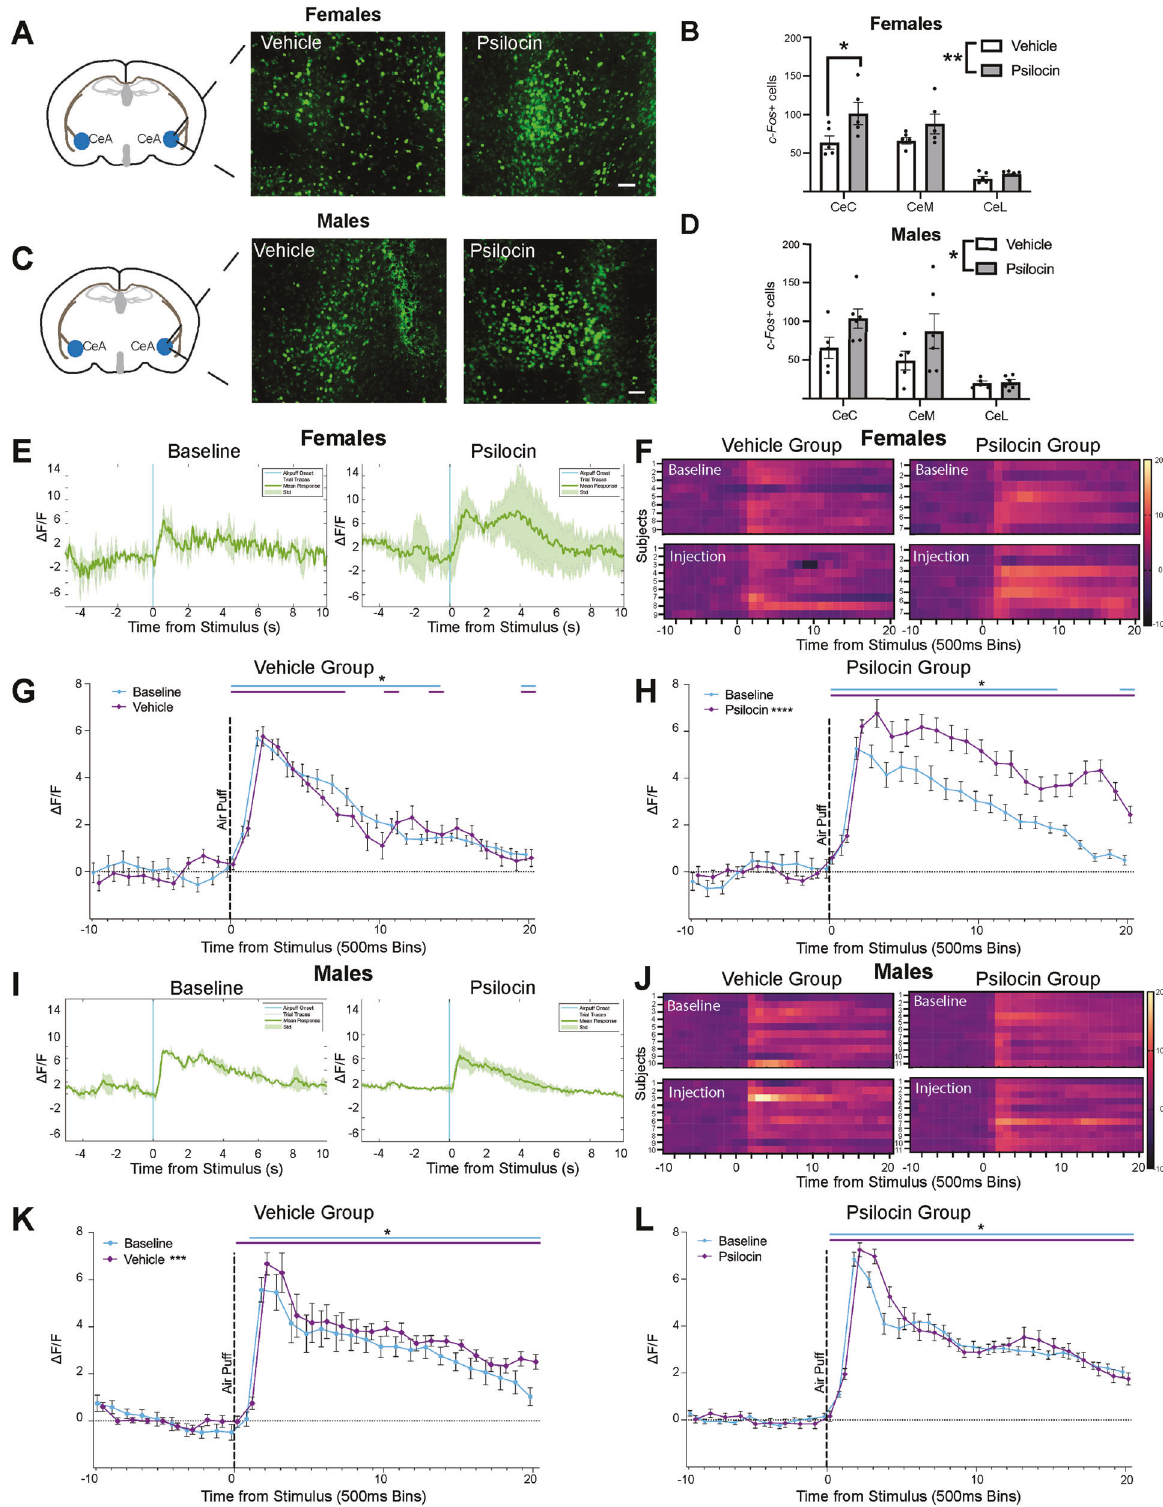
change in fl uorescence as a function of baseline ( Δ F / F ). Traces were analyzed 5 s before and 10 s following administration of air-puff (Fig. 1C). Following injection of the drug, animals were not assessed for any behavioral indices of hallucination (i.e., head twitch, wetback